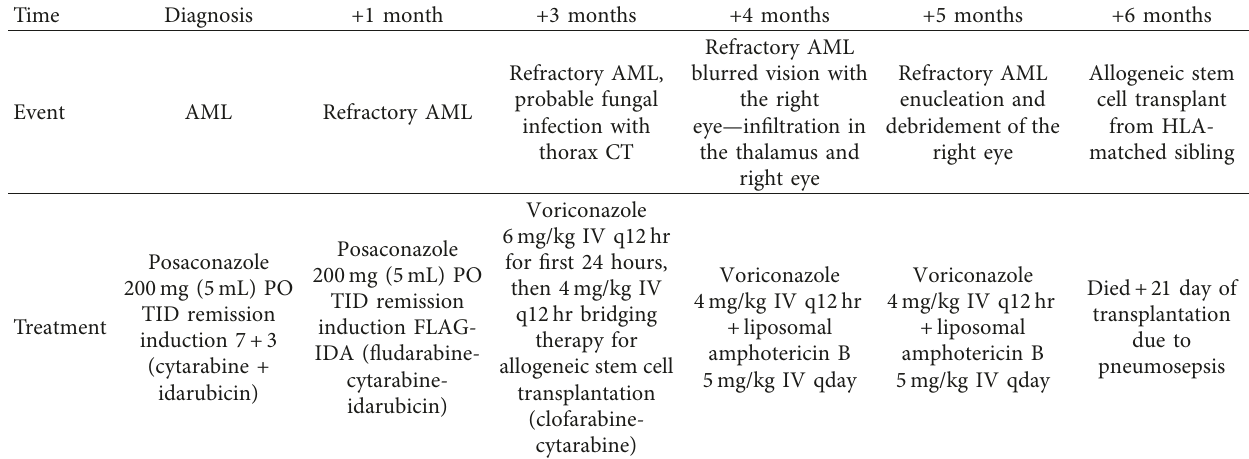
Table 1: Follow-up and course of the